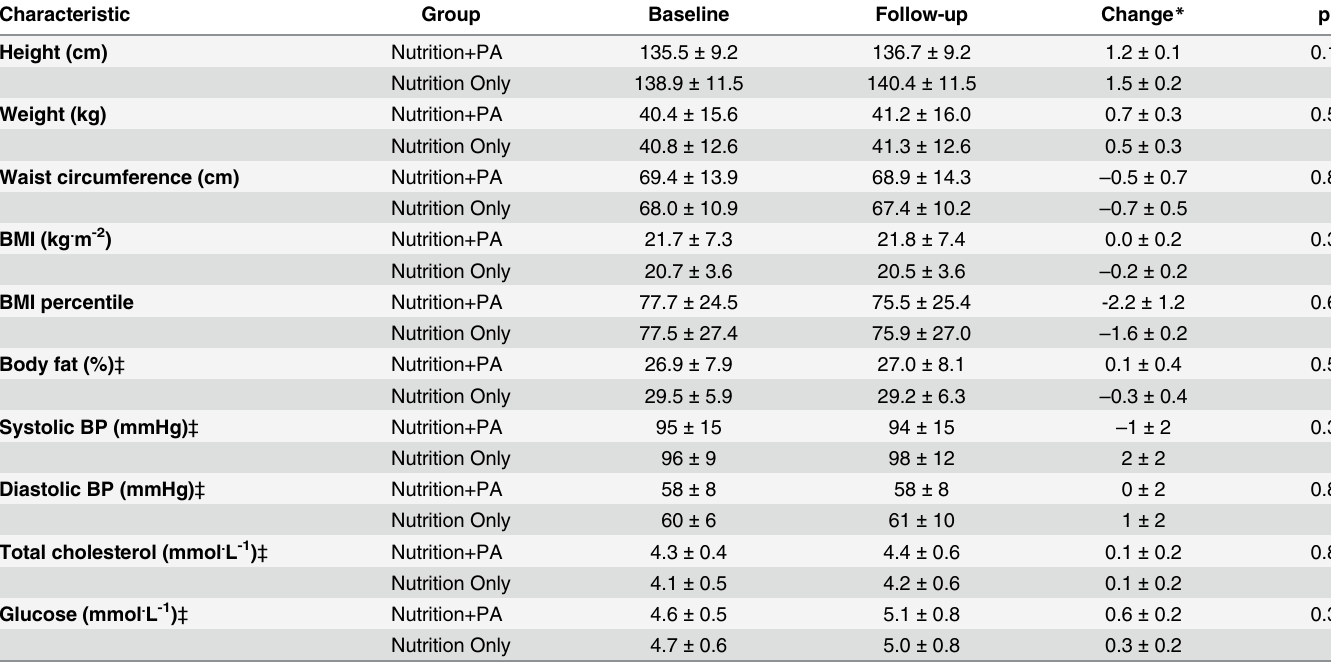
* Unadjusted mean change ± standard error. All within-group mean changes were non-signi fi cant, p > 0.05. † From Student t-test comparing mean change in nutrition+PA and nutrition only participants (N = 36). Signi fi cance of the comparison was unaffected by adjustment for age or effect modi fi cation by wave or weight stratum. ‡ For change in percent body fat by bioelectrical impedence testing: nutrition only n = 16; nutrition+PA n = 16. For blood pressure: nutrition only n = 18; nutrition+PA n = 17. For labs: nutrition only n = 16; nutrition+PA n = 15. BMI, body mass index; BP, blood